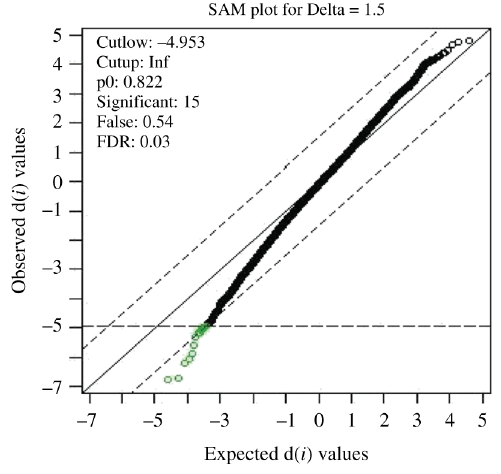
Figure 6: Between group comparisons in SAM analysis